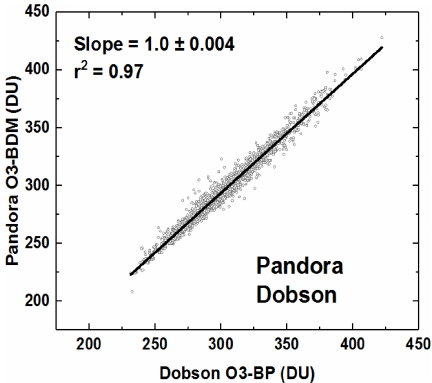
Figure 4. Correlation between Pandora #034 and Dobson #061